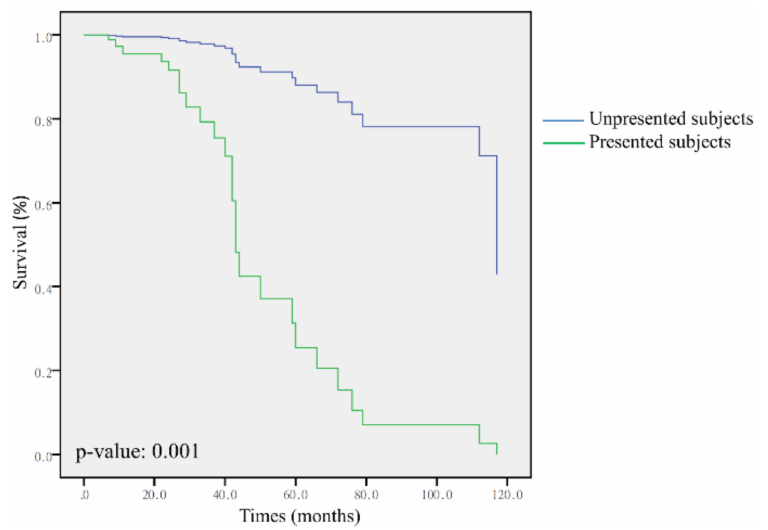
Figure 4. Multivariate survival analysis according to presence or non-presence bacteria in patients with lung